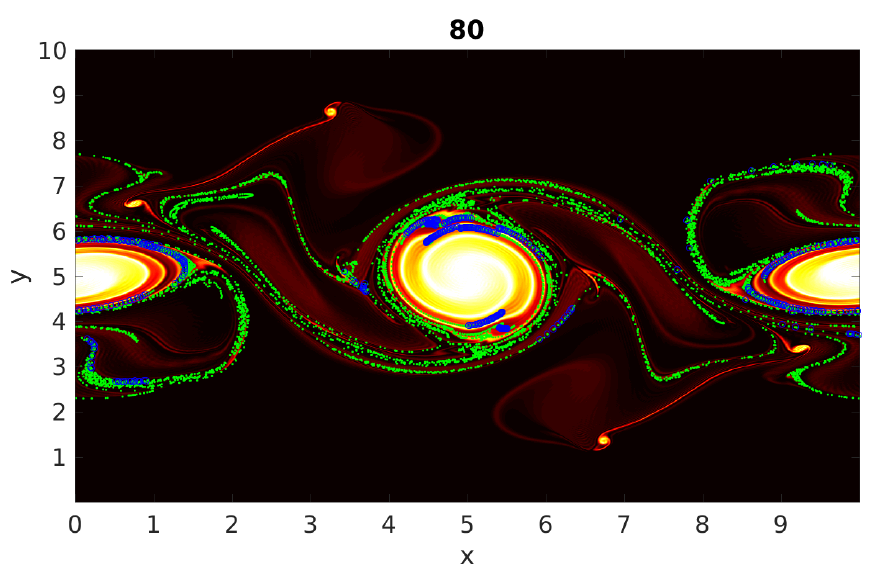
Figure 17. Enstrophy field with particles at output time 80. The green dots represent particles from the three largest cumulative clusters, and the blue regions represent particles having dense interactions within these cumulative